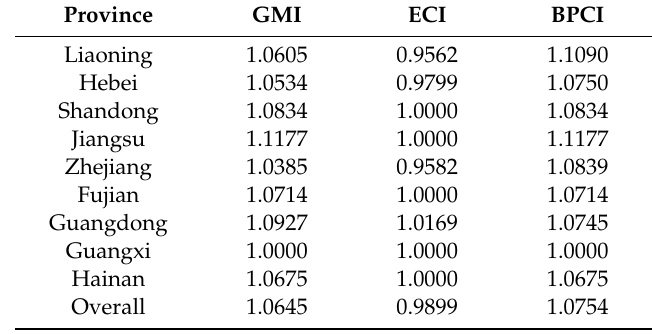
Table 5. Geometric mean of the change rate in the marine aquaculture e ffi ciency in China, 2004–2016.